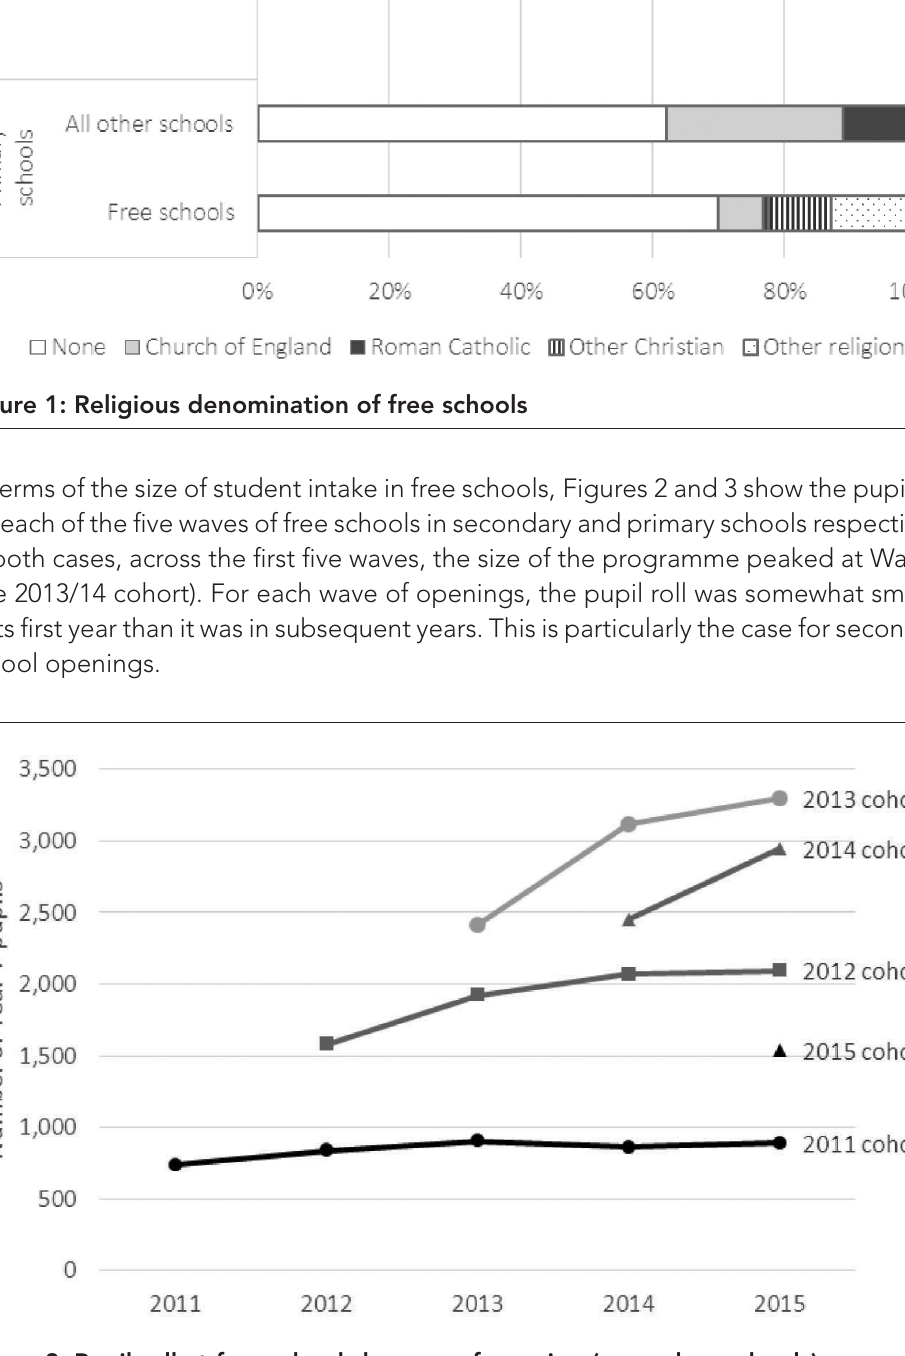
Figure 2: Pupil roll at free schools by year of opening (secondary